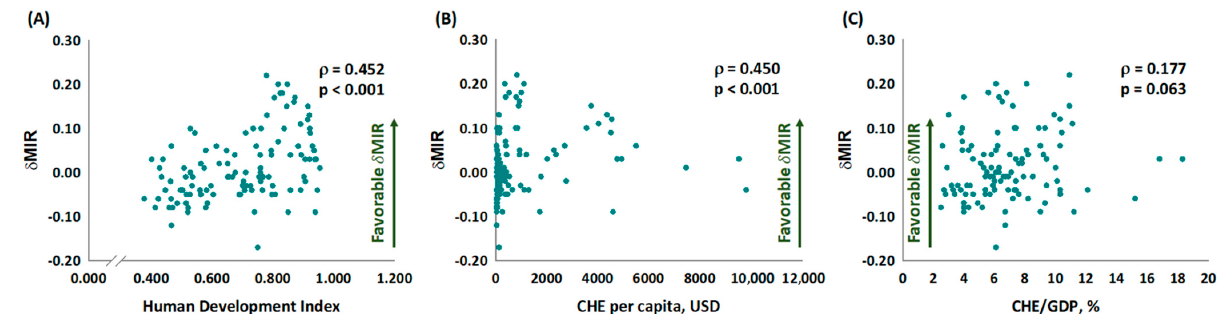
Figure 3. The ( A ) human development index and ( B ) current health expenditure per capita are sta- tistically associated with 𝛿 MIR in liver cancer. The current health expenditure as a percentage of the gross domestic product ( C ) is not significantly associated with the 𝛿 MIR in liver cancer.